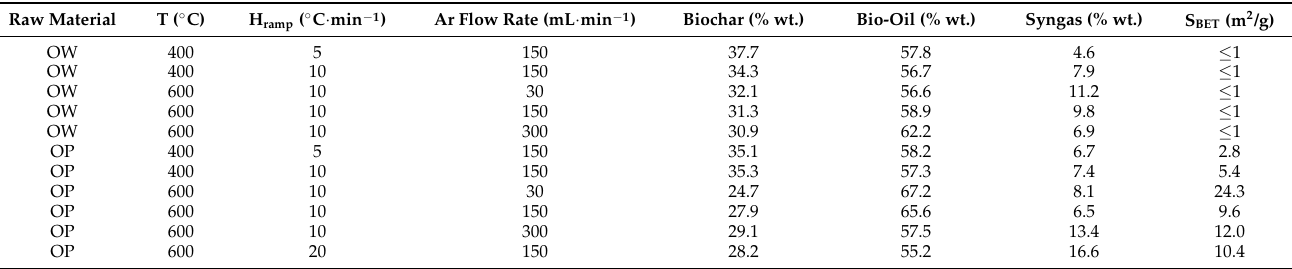
Table 2. Material balance of the performed